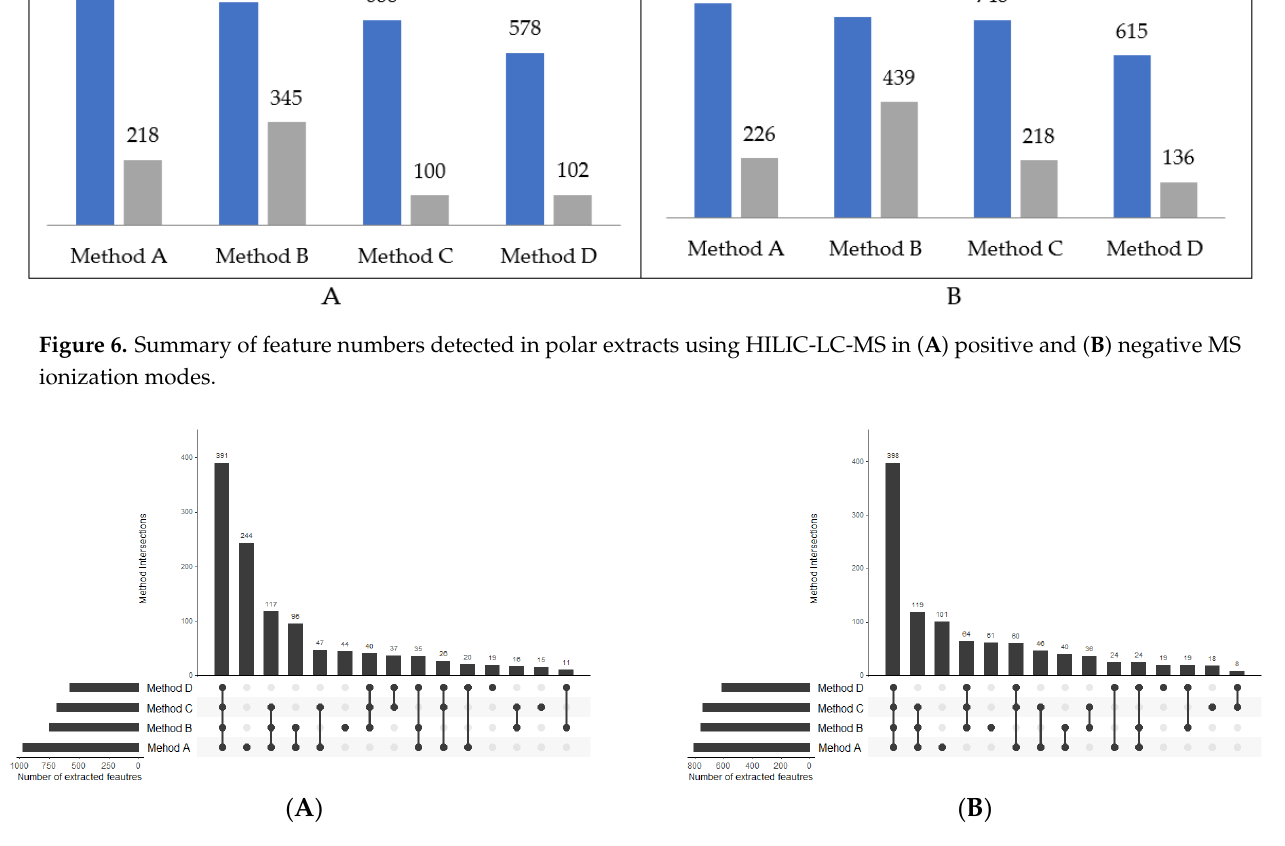
Figure 7. UpSet plots presenting the overlap between compared extraction methods in terms of polar compounds detected in ( A ) positive and ( B ) negative MS ionization modes.